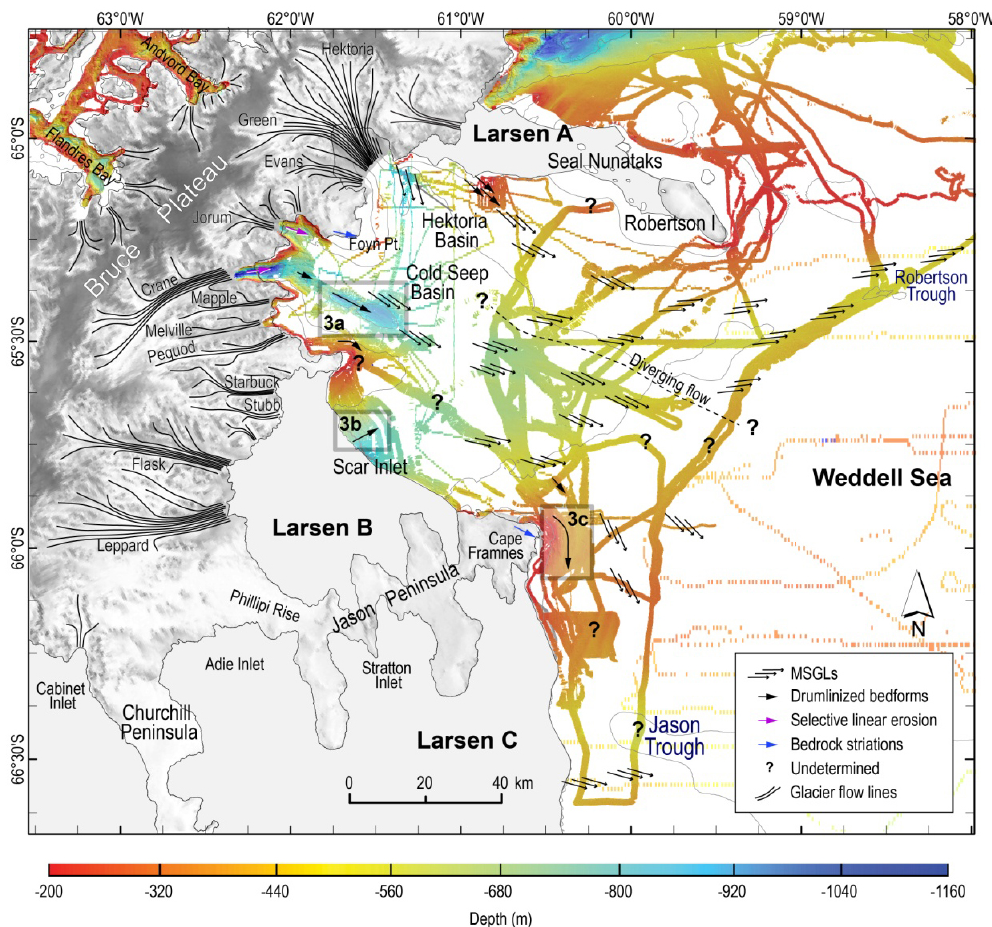
Figure 2. Details of seabed morphology in Larsen B embayment associated with paleo-flow-line trajectories based on examination of swath bathymetry imagery of the seafloor. Distinct flow trajectories split the Larsen B embayment into two outlets by ice-flow bifurcation. The bathymetry contour interval of 250m is from IBCSO (Arndt et al., 2013). The gray boxes show the regions detailed in Fig. 3. For location see Fig.